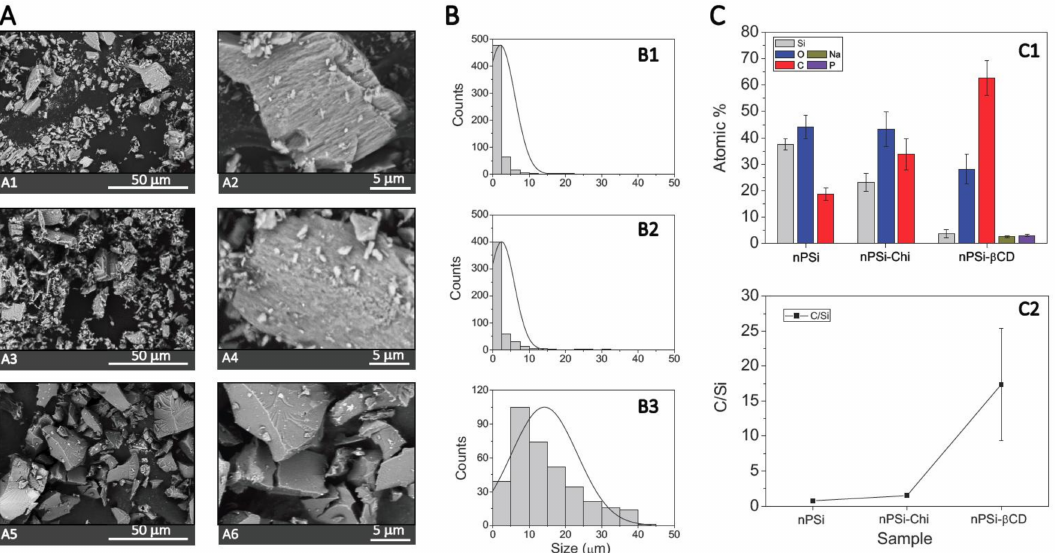
Figure 3. ( A ) Scanning electron microscope images (SEM) of samples at the di ff erent stages of synthesis: ( A1 , A2 ) for nPSi, ( A3 , A4 ) for nPSi-Chi, ( A5 , A6 ) for nPSi- β CD. ( B ) Histograms of particle size distribution: ( B1 ) for nPSi, ( B2 ) for nPSi-Chi, ( B3 ) for nPSi- β CD. ( C ) Atomic % and C / Si ratio of samples obtained from energy-dispersive X-ray analysis (EDX), ( C1 , C2 ),